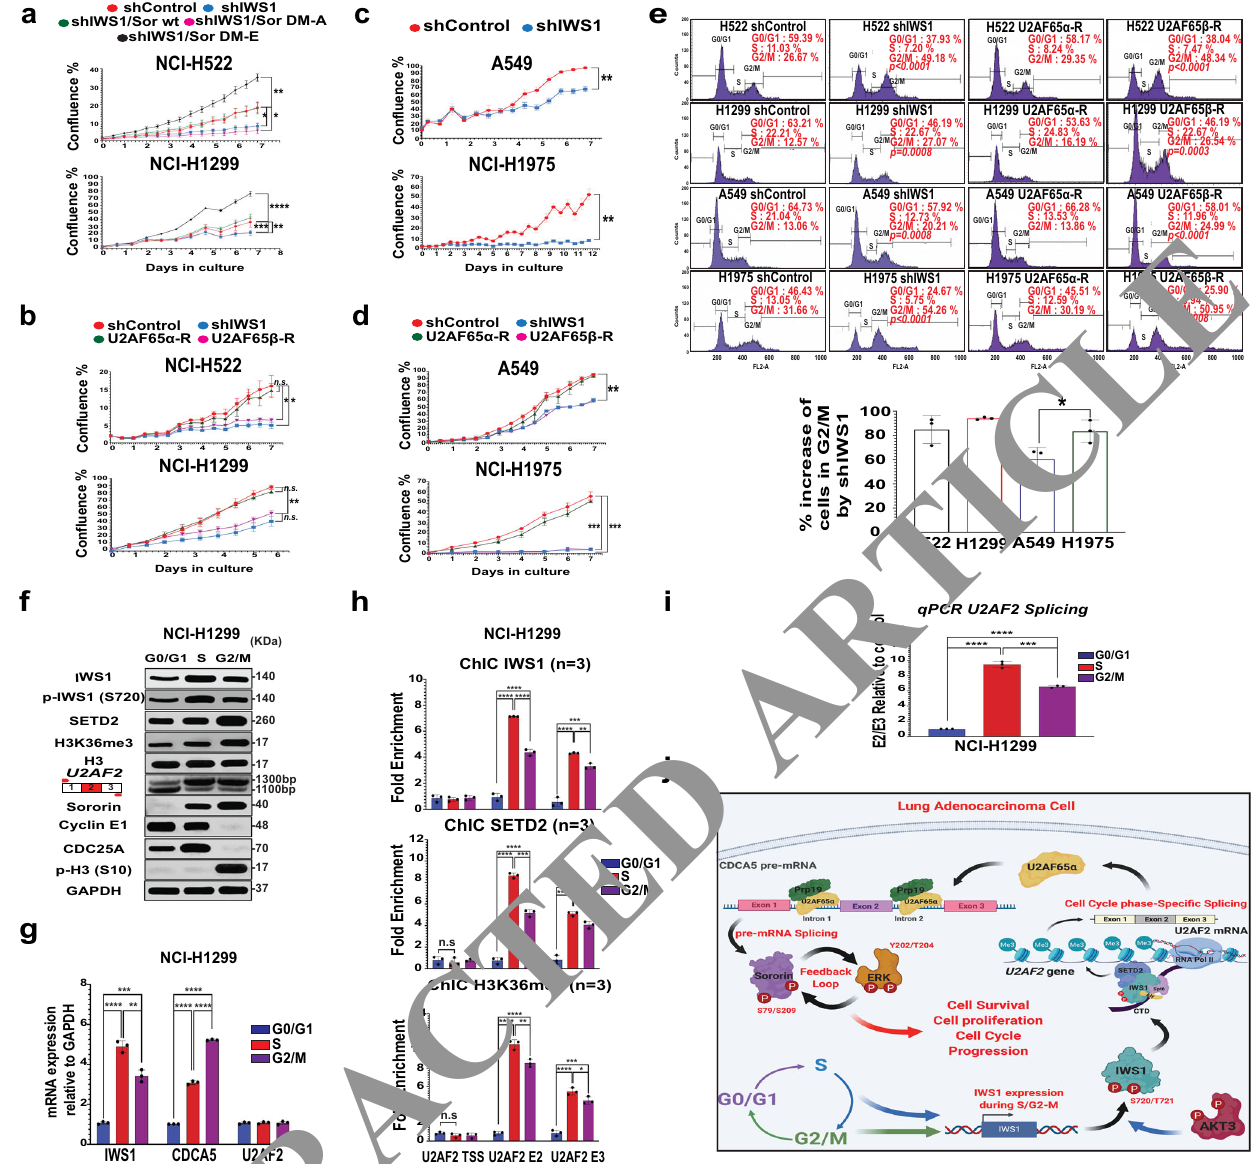
Fig. 6 IWS1 phosphorylation promotes cell proliferation by controlling a Sororin/ERK phosphorylation feedback loop, through U2AF2 RNA splicing. a , b Growth curves of shControl and shIWS1 NCI-H522 and NCI-H1299 cells, growing in fully supplemented media, before and after rescue with Sororin (wt or mutants), or U2AF65 α /U2AF65 β . Experiment was done in triplicate and proliferation was expressed as mean percent con fl uence ±SD. P values (one-sided unpaired t -test) were calculated for the endpoint measurements. * p < 0.05, ** p < 0.01, *** p < 0.001, **** p < 0.0001. b Growth curves of shControl and shIWS1 A549 and NCI-H1975 cells. c Growth curves of the same shIWS1 cells rescued with U2AF65 α or U2AF65 β . Proliferation in panels c and d was measured as in panels a and b . d (Upper panel) Cell cycle pro fi les of the indicated propidium iodide (PI)-stained cell lines. One representative, out of three biological replicates. Mean percentages of cells in different cell cycle phases in red. (Lower panel) shIWS1-induced percent change of cells in G2/M±SD. Statistical analysis was performed using a one-sided unpaired t -test, * p < 0.05. Gating strategy in supplementary fi gure 8a. e NCI-H1299 cells were sorted into G0/G1, S and G2/M fractions. Lysates of sorted cells were probed with the indicated antibodies. RT-PCR on RNA from the same cells, using primers for U2AF2 exons 1 and 3. Gating strategy in supplementary fi gure 8a. f qRT-PCR-determined expression of IWS1 , CDCA5 and U2AF2 , relative to GAPDH±SD. SD was calculated based on three biological replicates. g ChIC-determined mean fold enrichment of IWS1, SETD2 and H3K36me3 in cell cycle fractionated cells in the indicated regions of the U2AF2 RNA±SD. h qRT-PCR-based calculation of the mean U2AF2 E2/E3 ratio in S and G2/M, relative to G0/G1 cells ±SD. SD was calculated based on three biological replicates * p < 0.05, ** p < 0.01, *** p < 0.001, **** p < 0.0001. (one-sided unpaired t -test). i IWS1 expression is induced during the S and G2/M phases of the cell cycle. Following phosphorylation by AKT3, IWS1 orchestrates the cell cycle- dependent assembly of epigenetic complexes on the U2AF2 gene. This promotes the inclusion of exon 2 in the U2AF2 mRNA. U2AF65 α , encoded by the exon 2-containing U2AF2 mRNA, interacts with Prp19, promoting CDCA5 splicing and the expression of Sororin. The latter is phosphorylated by ERK, and promotes ERK phosphorylation, in a positive feedback loop, which stimulates proliferation of lung